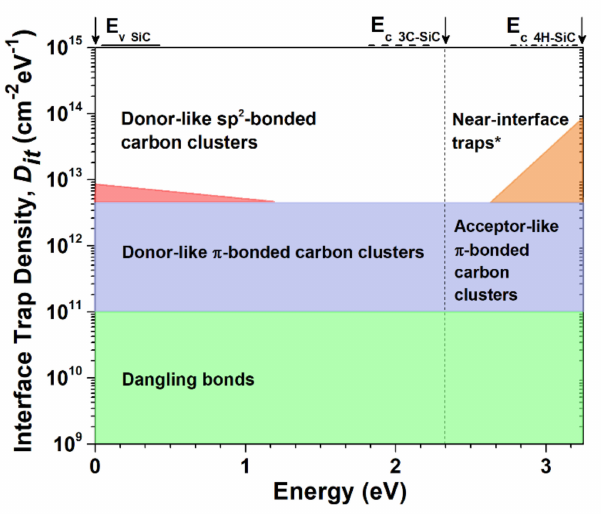
Figure 6. Schematic representation of the “carbon cluster model”. Adapted from Ref. [71] with permission from the author (R.